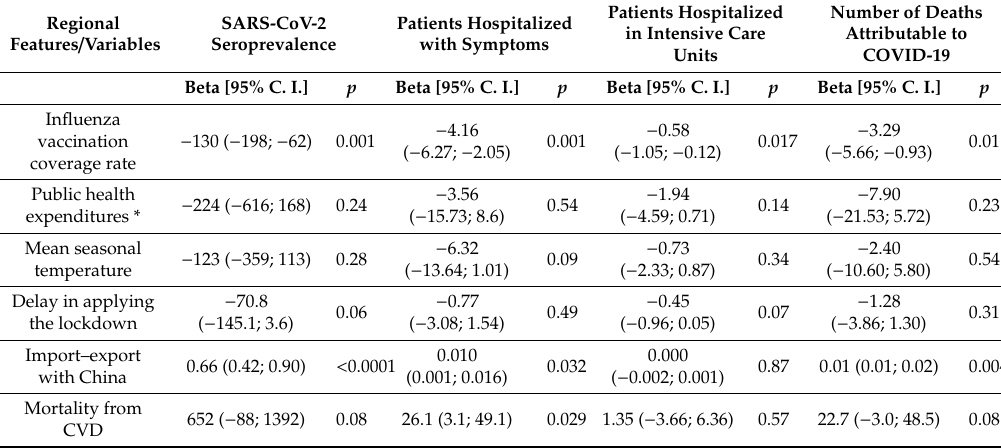
Table 2. Multivariable relationships between regional influenza vaccination coverage rate in the Italian population aged 65 and over and COVID-19